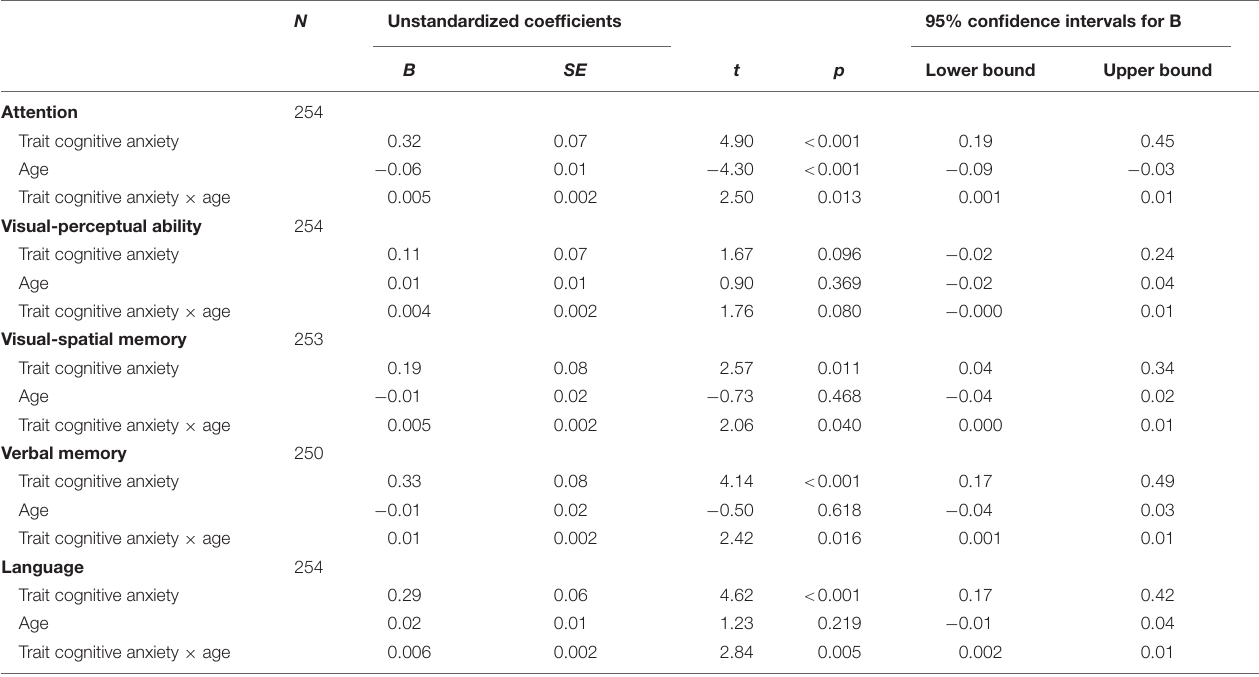
TABLE 3 | Unstandardized coefficients, significance tests, and 95% confidence intervals for predictors of subjective cognitive difficulties in each moderated regression analysis including trait cognitive anxiety as a predictor. N Unstandardized